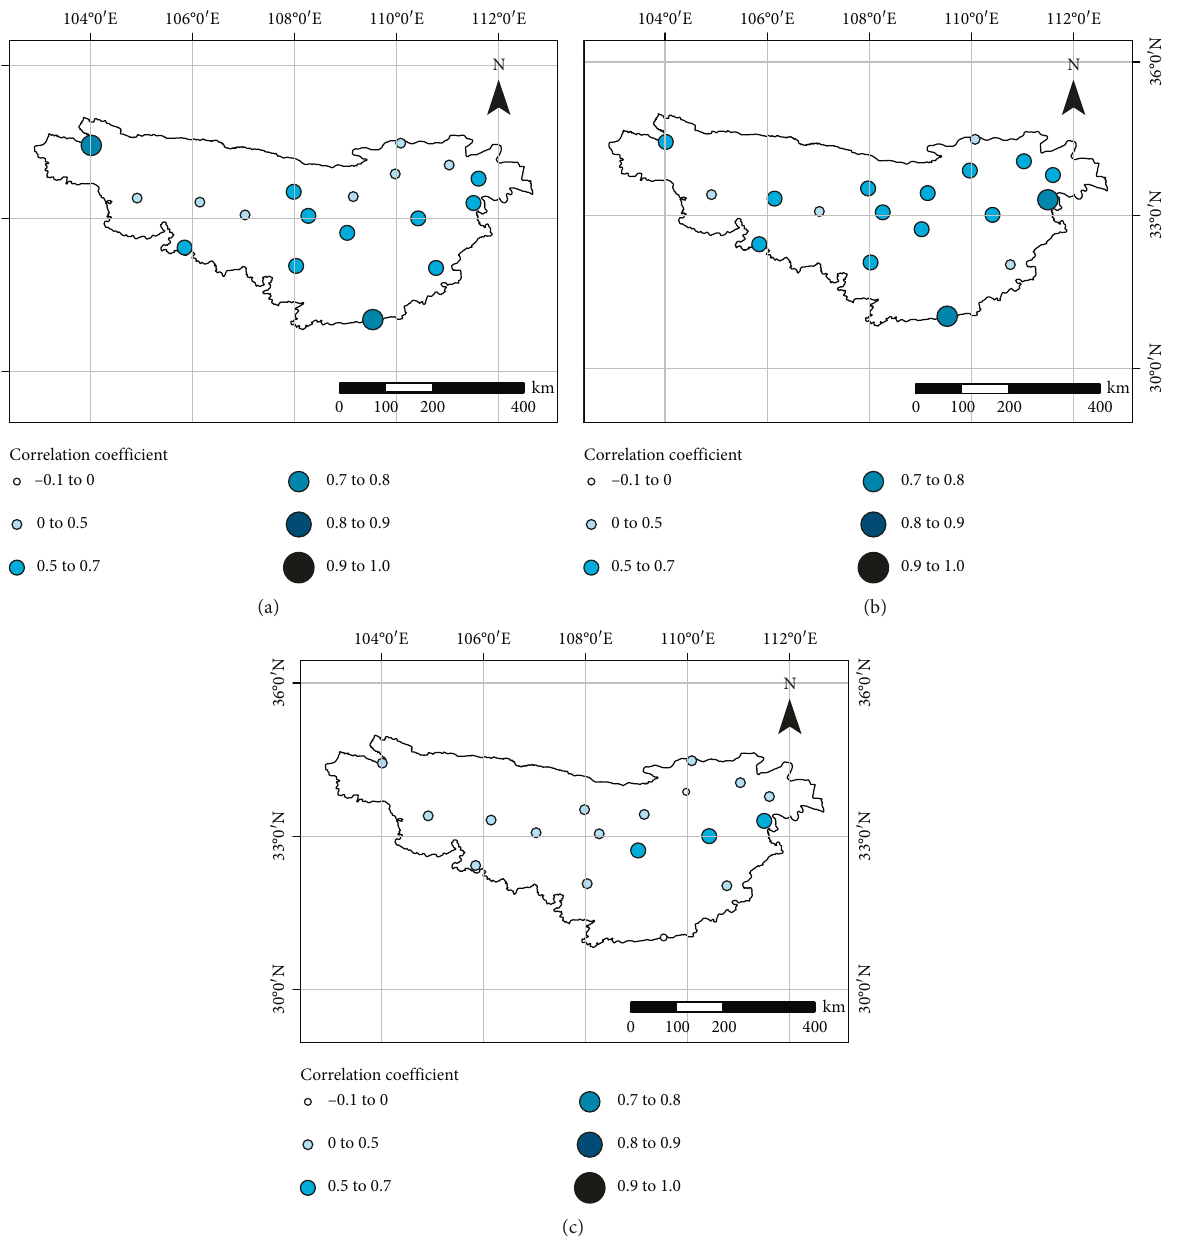
Figure 7: Correlation coefficient at each gauge over the Qinling-Daba Mountains for annual precipitation between (a) ERA-Interim and gauges, (b) JRA-55 and gauges, and (c) NCEP/NCAR-1 and